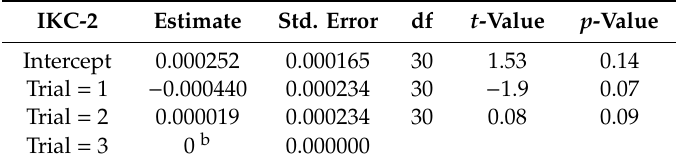
Table 6. Significant di ff erences among the mean of VR obtained per trial in IKC-2. IKC-2